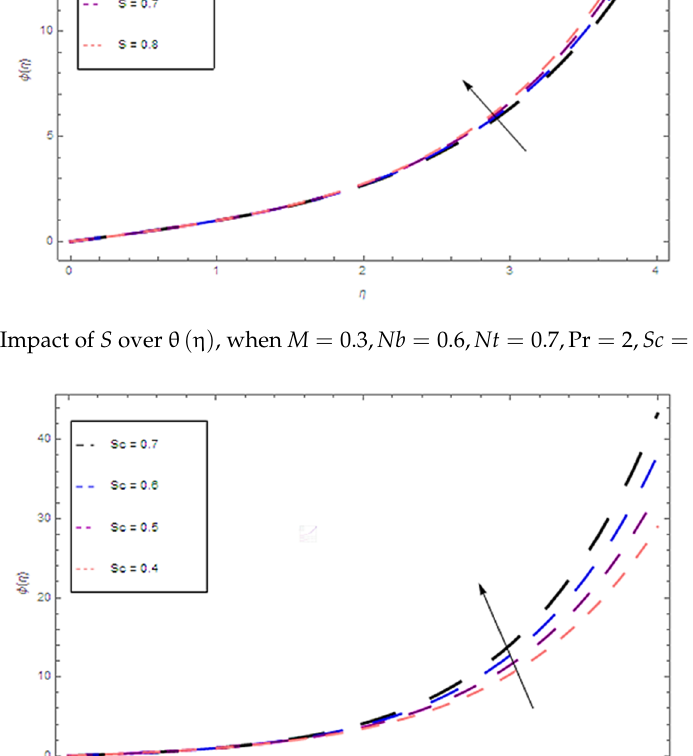
Figure 17. Impact of Sc on θ ( η ) , when